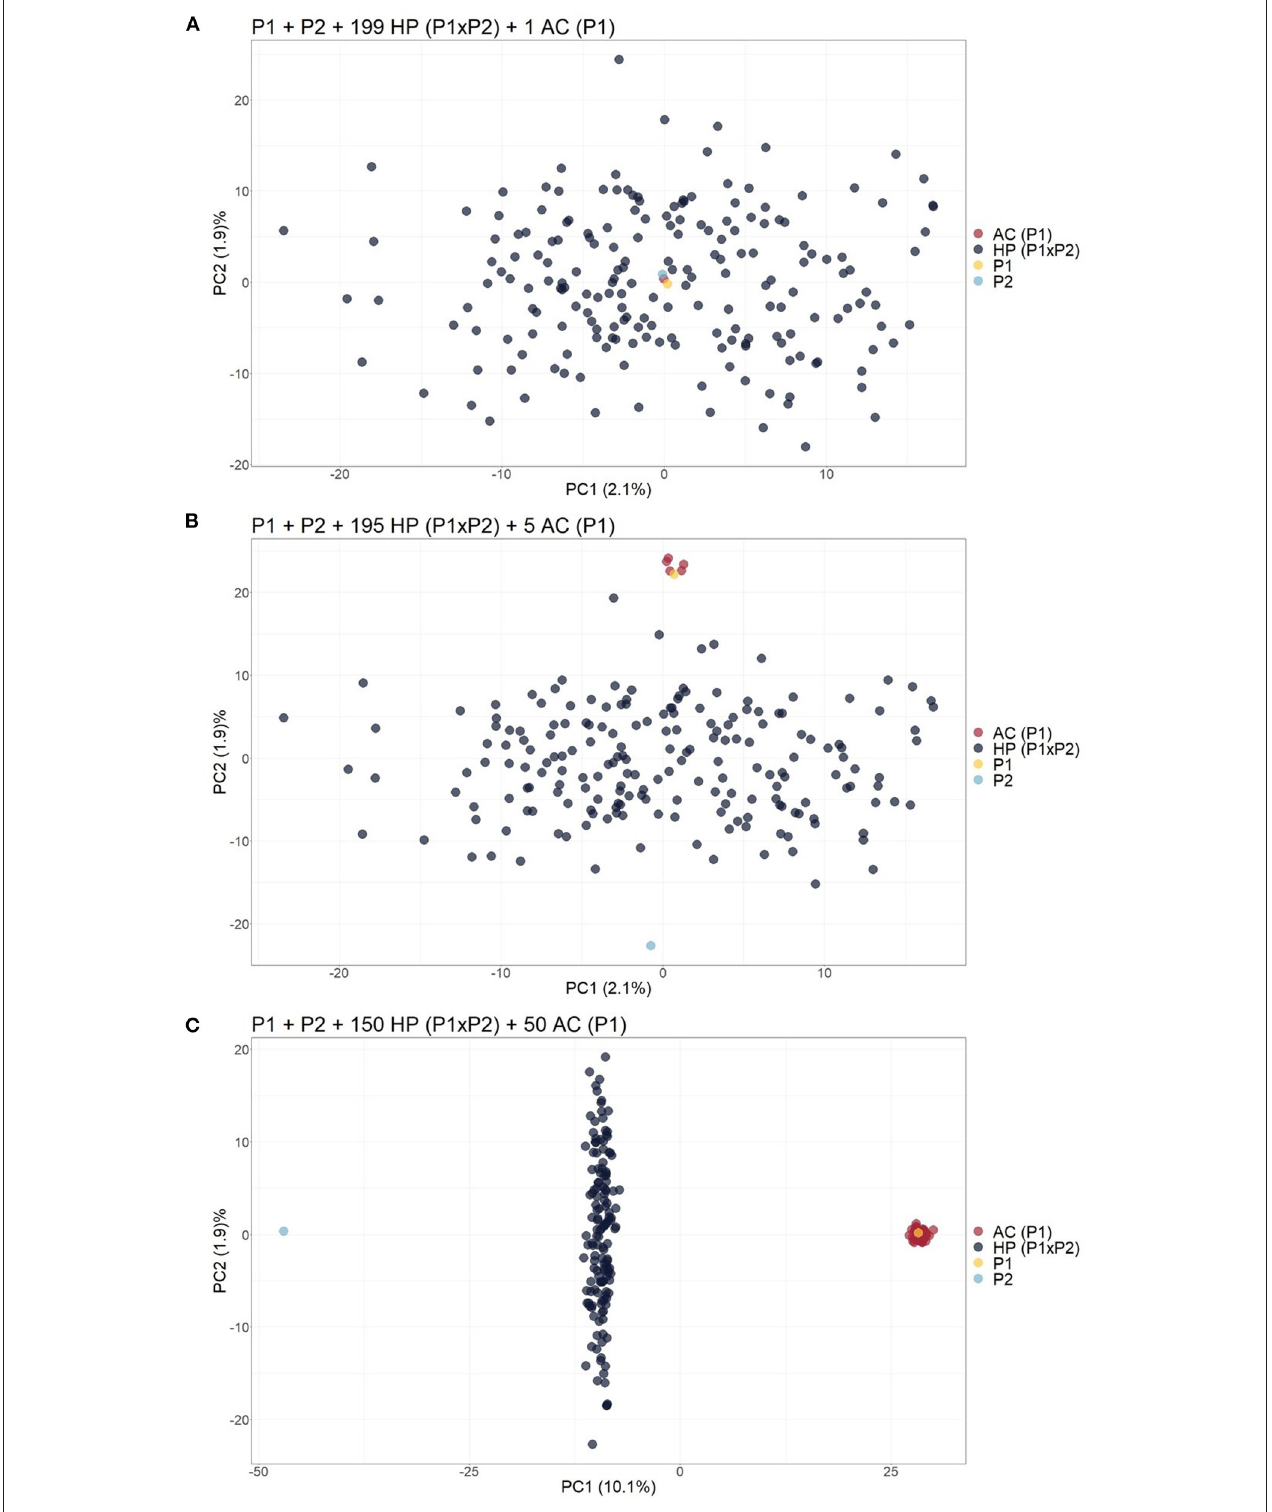
FIGURE 2 | Principal component analysis (PCA)-based scatter plots showing the change in dispersion pattern as the apomictic clone (AC) of P1 increases in frequency in the simulated population. (A) Progeny with 199 hybrids (HPs) and 1 AC; (B) Progeny with 195 HPs and 5 ACs; (C) Progeny with 150 HPs and 50 ACs. The axis represents the first and second principal components, explaining 2.1% and 1.9% of the variance, respectively, for (A) , 2.1% and 1.9% for (B) and 10.1% and 1.9% for (C) .